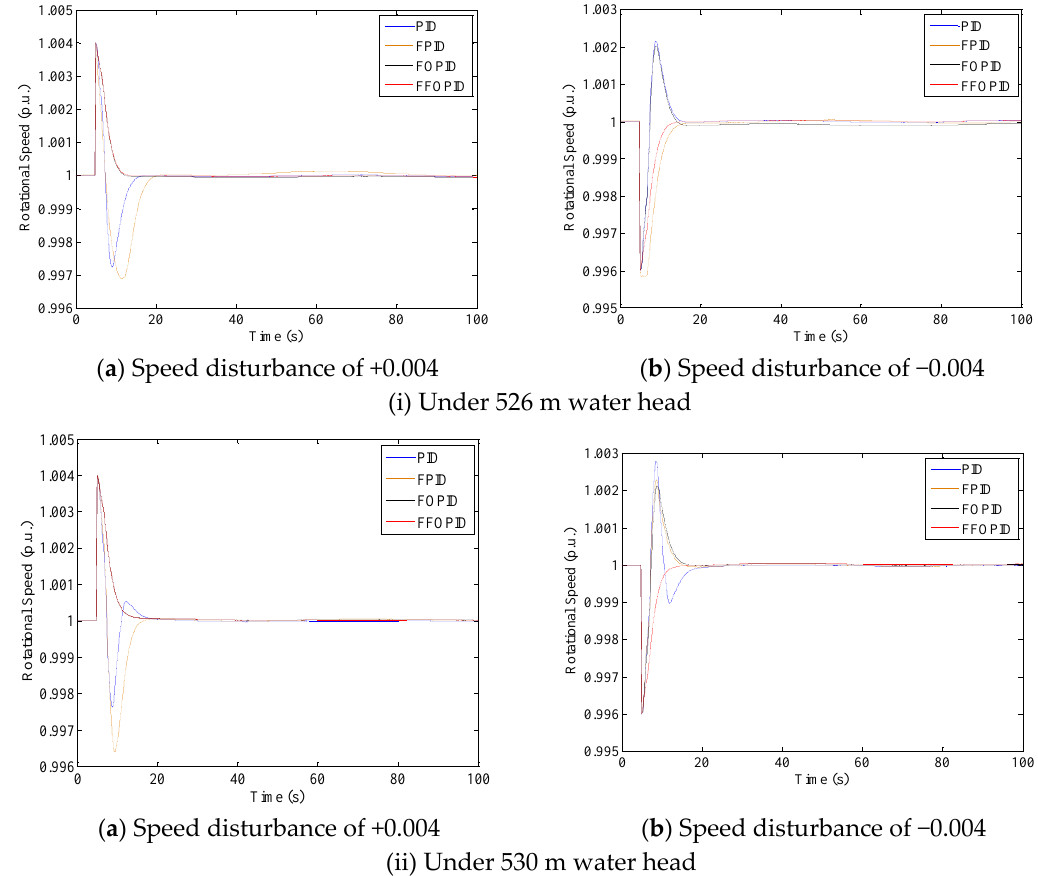
Figure 13. Robustness of the FFOPID controller for variation in rotational speed disturbance.